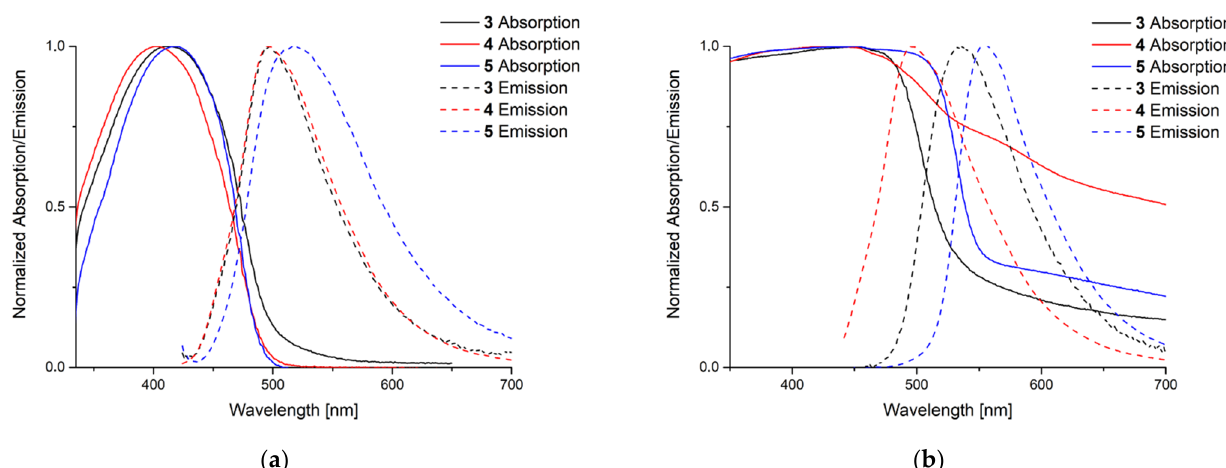
Figure 5. Recorded absorption and emission spectra in solution and solid state. For the emission spectra the respective absorption maximum was chosen as excitation wavelength ( λ Ex ). ( a ) Measure- ment in solution (DCM) λ Ex [nm] = 414 ( 3 ), 402 ( 4 ), 417 ( 5 ); ( b ) in solid state λ Ex [nm] = 451 ( 3 ), 427 ( 4 ), 450 ( 5